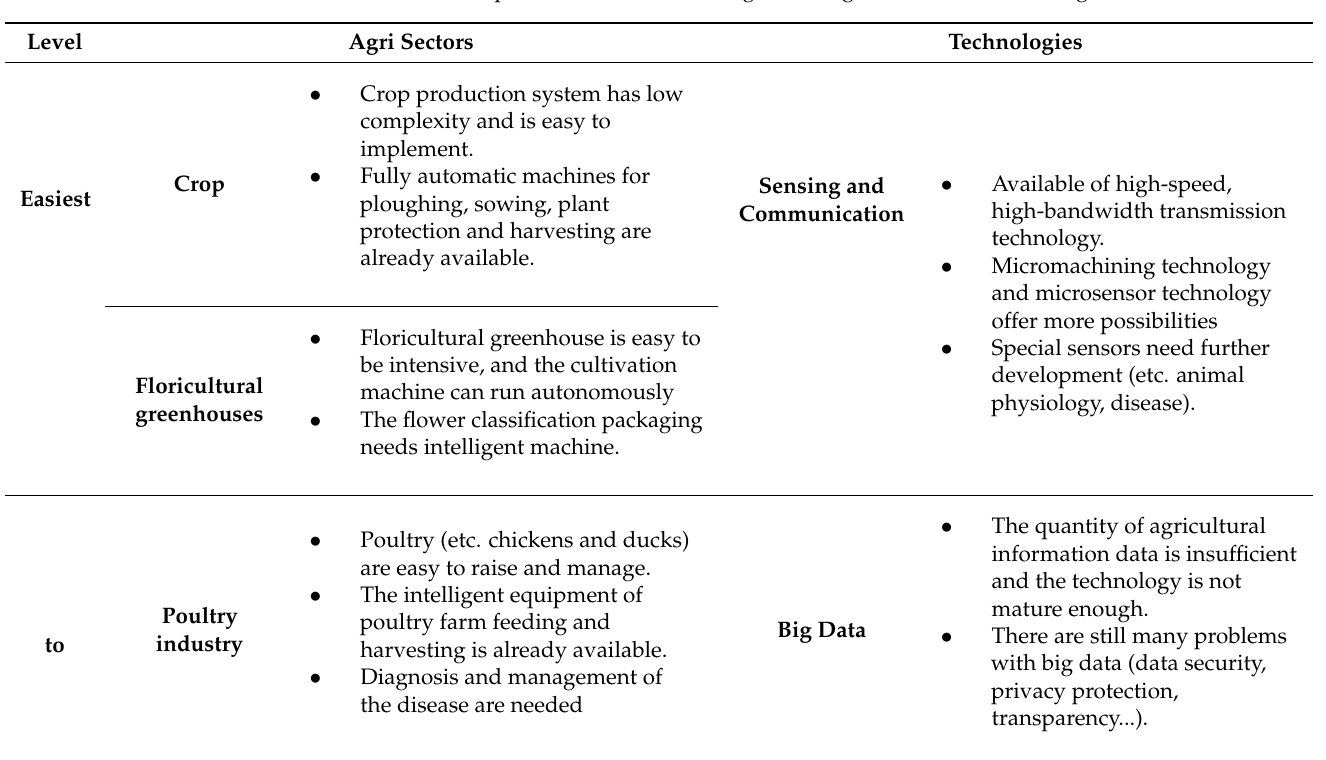
Table 1. The convenient areas for implementation of technologies through unmanned farm in agri sectors. Level Agri Sectors Technologies